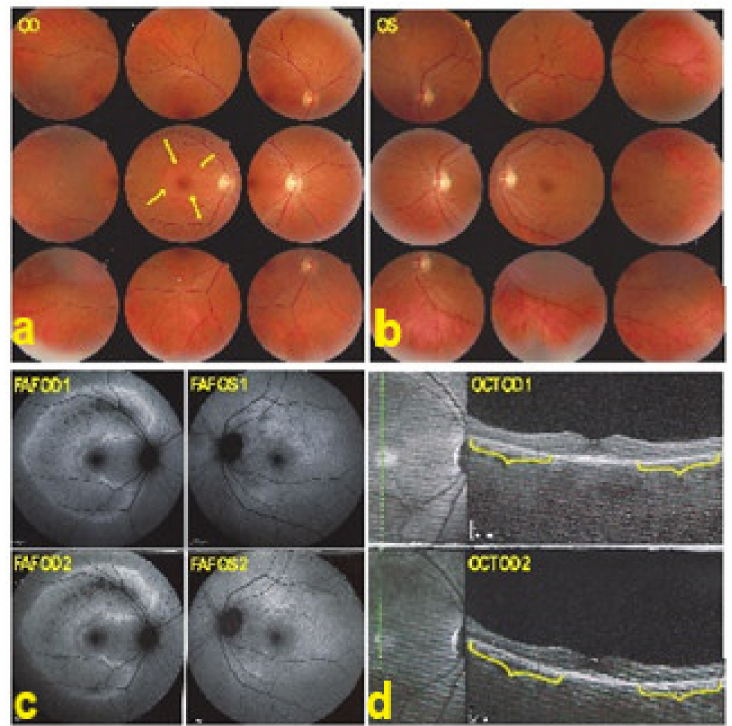
Figure 36. AZOOR. Fundus photograph showing a pale ring around the fovea OD (arrows) ( a ) and normal OS ( b ). In ( c ) Fundus autofluorescence (FAF) shows an extensive C-shaped hyperautoflu- orescent area around the fovea with dots of hypoautofluoresce within this zone OD. (FAF OD 1) Left hyperautofluorescence parapapillary inferiorly and supero-temporally to the fovea. (FAF OS 1), corresponding to the loss of photoreceptors on SD OCT, extensive in OD (brackets in OCT OD 1 ( d )), with a stable evolution after infliximab therapy (FAFOD/OS 2 and brackets in OCT OD 2 ( d